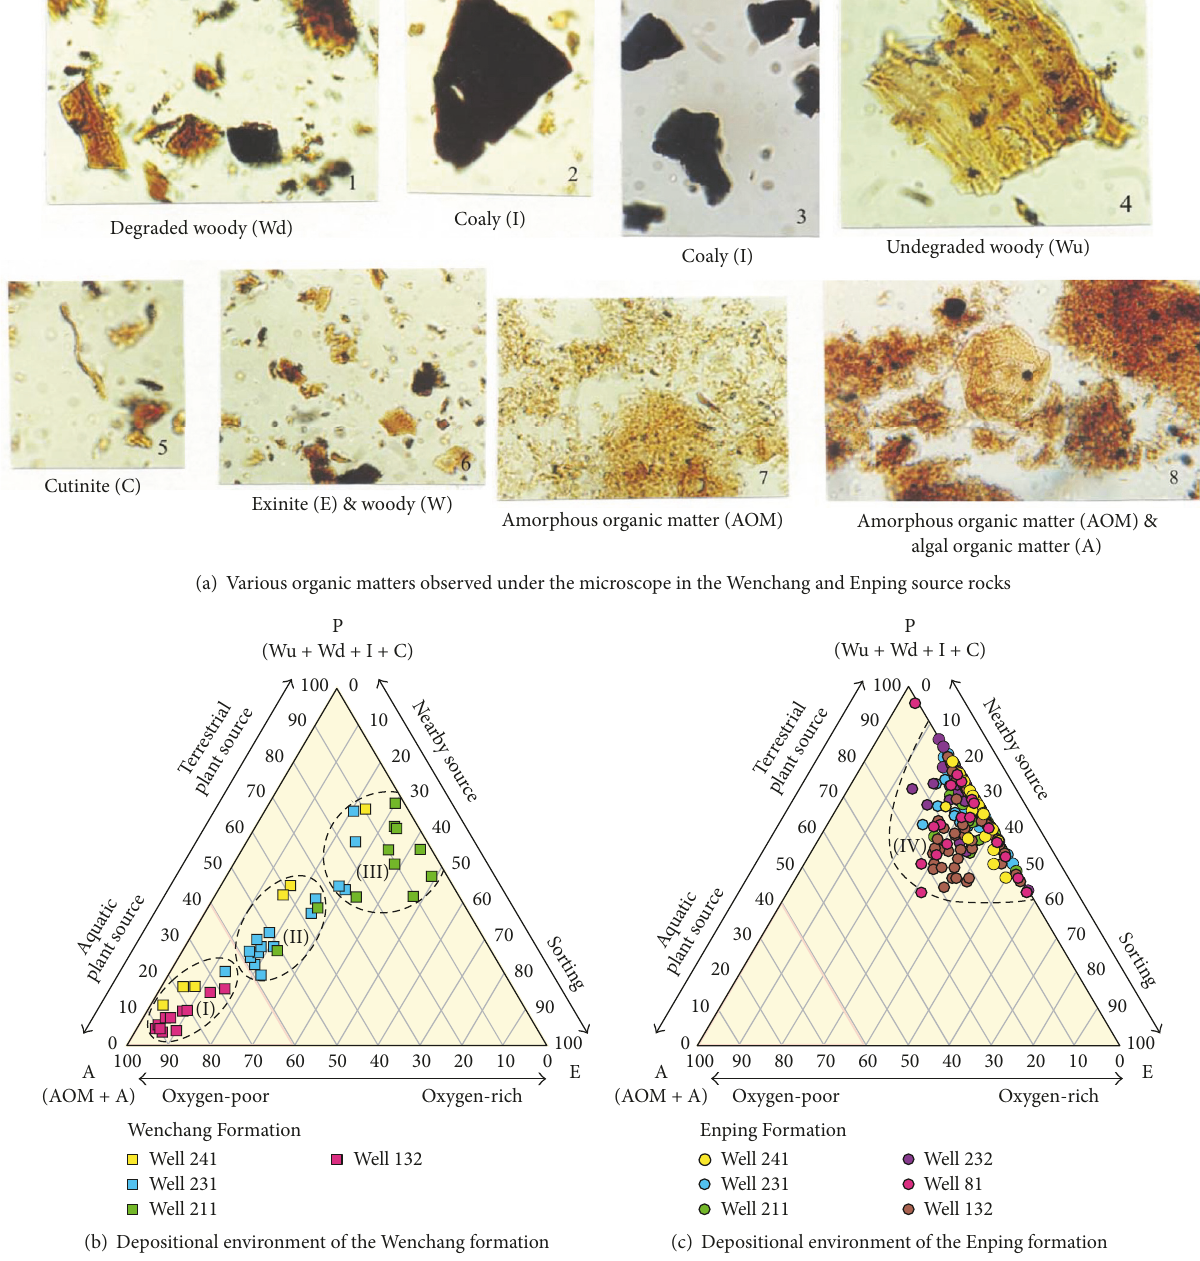
Figure 5: Organic constituent (a) and P-A-E ternary diagrams of Wenchang source rocks (b) and Enping source rock (c) (P: higher terrestrial plant; A: amorphous organic matter and alginite; E: exinite and sporonin). Data according to the internal reports of Shenzhen Company of CNOOC China